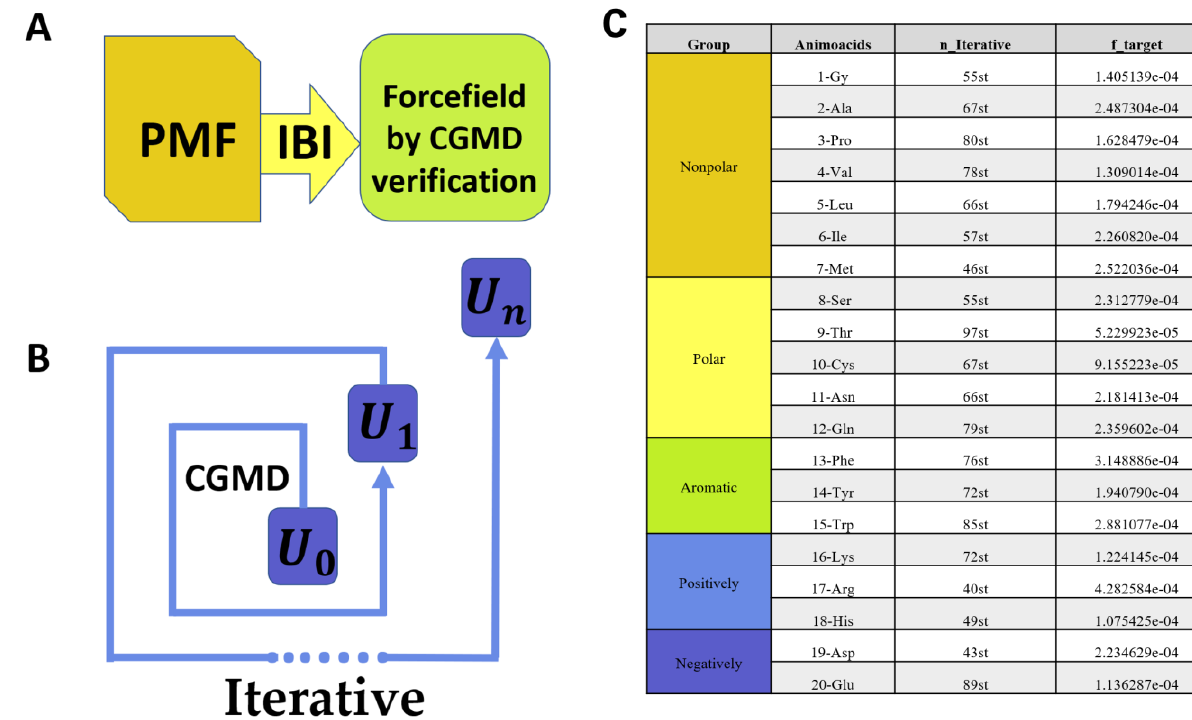
Figure 7. ( A ) Initialized by PMF, it then obtains a proven force field with IBI; ( B ) IBI through CGMD to generate a new potential energy function every iteration; ( C ) The accuracy of the decision function between the initial target radial distribution function of amino acids and CNT55L3 after IBI iterative optimization and the radial distribution function obtained by the best iteration.